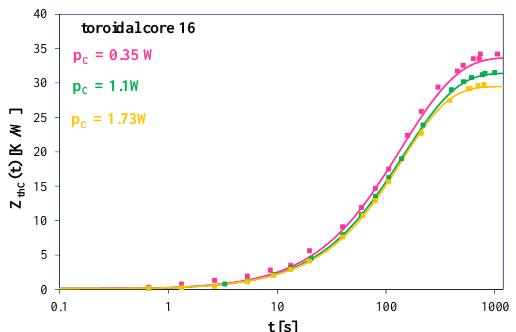
Figure 9. Measured and calculated waveforms of transient thermal impedances of the inductor containing the toroidal core 16.